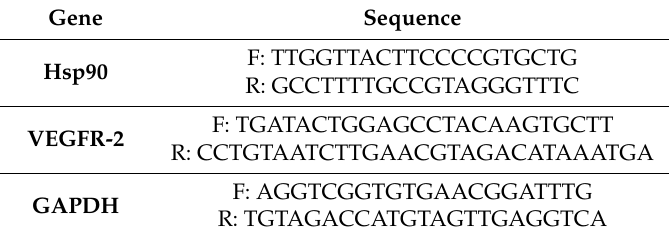
Table 4. Sequence of Hsp90, VEGFR-2, and GAPDH primers.